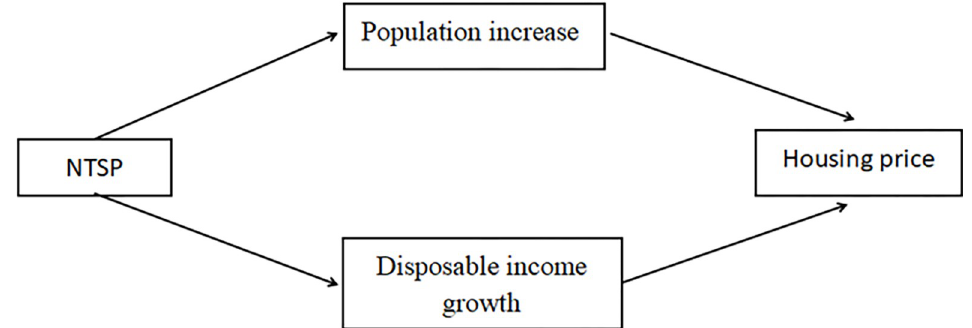
Fig 1. The mechanism by which NTSP affect housing